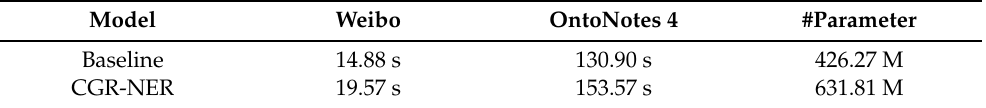
Figure 4. The variation tendency of evaluation metrics and loss value on the development set with the training epoch. ( a ) Weibo dataset; ( b ) OntoNotes 4 dataset. Table 4. The total number of parameters and the average time per epoch during training.